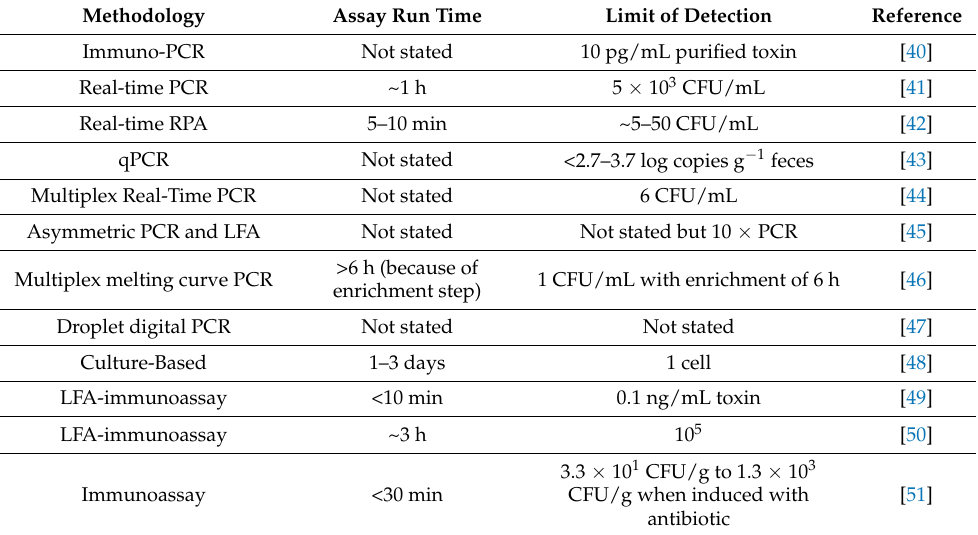
Table 2. Literature examples of different detection strategies for STEC bacteria, focused predomi- nantly on the detection of either the direct Shiga toxins or the stx1 and stx2 genes. Methodology Assay Run Time Limit of Detection Reference Immuno-PCR